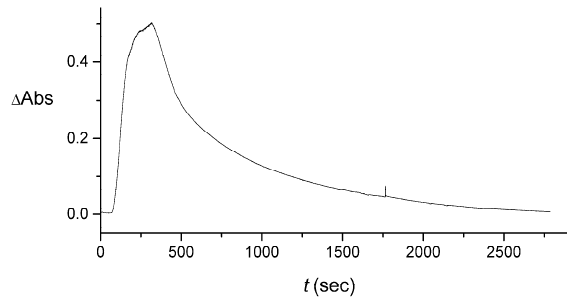
Figure 5. Example of the measured output signal, S p t q , produced with a commercially available cuvette, for a rectangular pulse. The numerically estimated decay time of the tail, 1/ K , cf. Equation (3), by data fitting for this system is nearly four times longer than the value for the systems shown in Figure 1.